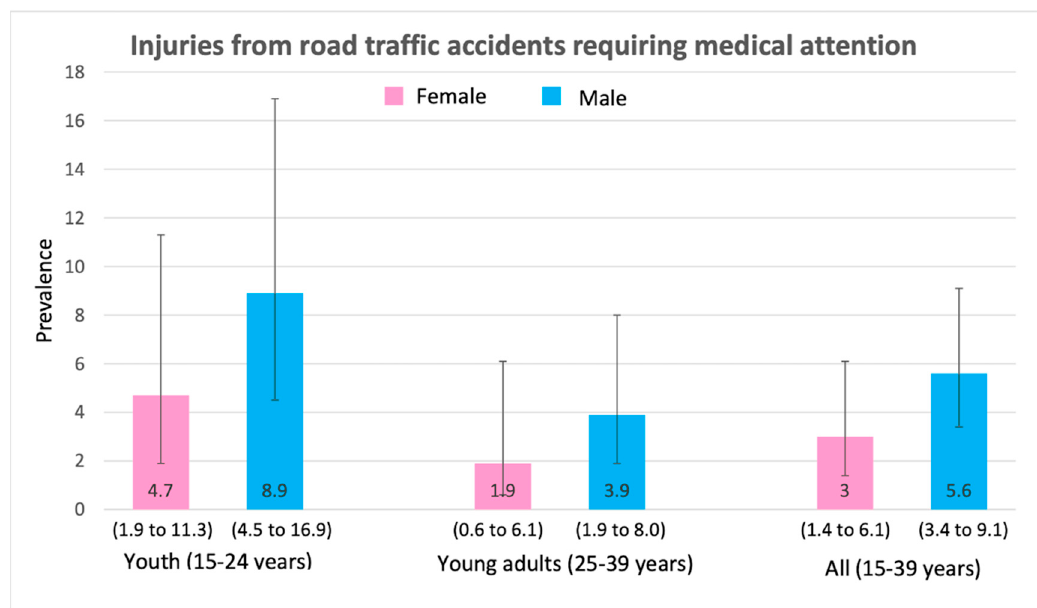
Figure 2. Prevalence (and 95% CI intervals) of injuries requiring hospital admission by age group and gender.